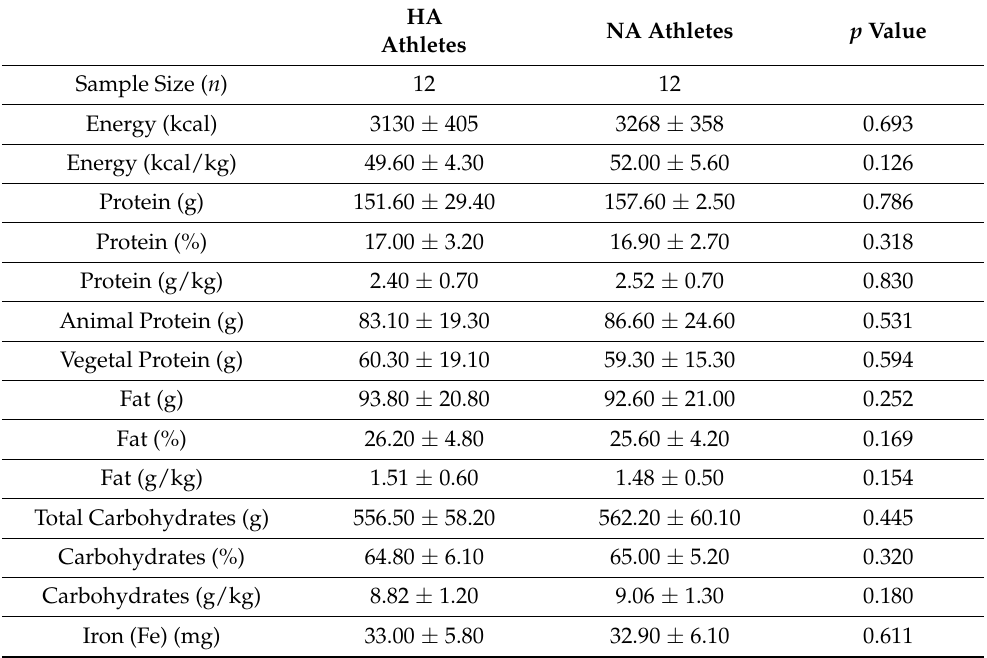
Table 5. The energy, macronutrient, and iron intake of the athletes in the two study groups during the 8 weeks of the